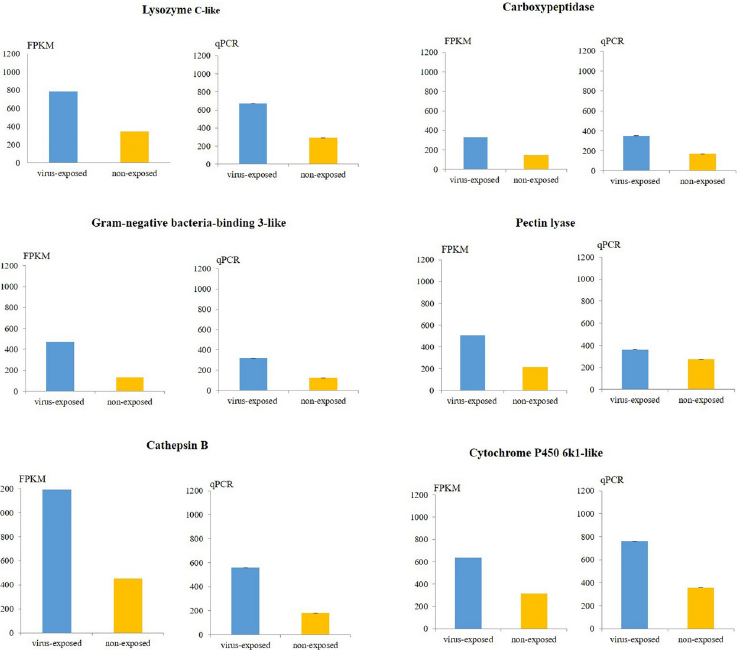
Fig 3. Validation of RNA-Seq gene expression by qPCR. FPKM values obtained by RNA-Seq analysis and relative expression levels obtained by qPCR for six selected genes in CaCV-exposed and non-exposed Thrips palmi are shown. Values were multiplied by a factor of 1000. Error bars represent the standard error for three biological